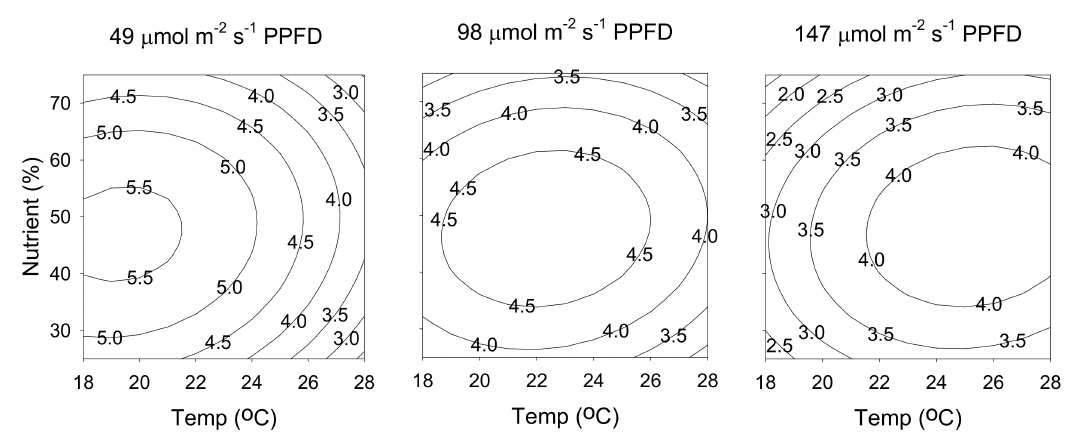
Figure 6. Contour plots of hyperforin content. The numbers inside the contour plots indicate content (mg / g) at given cultivated conditions.